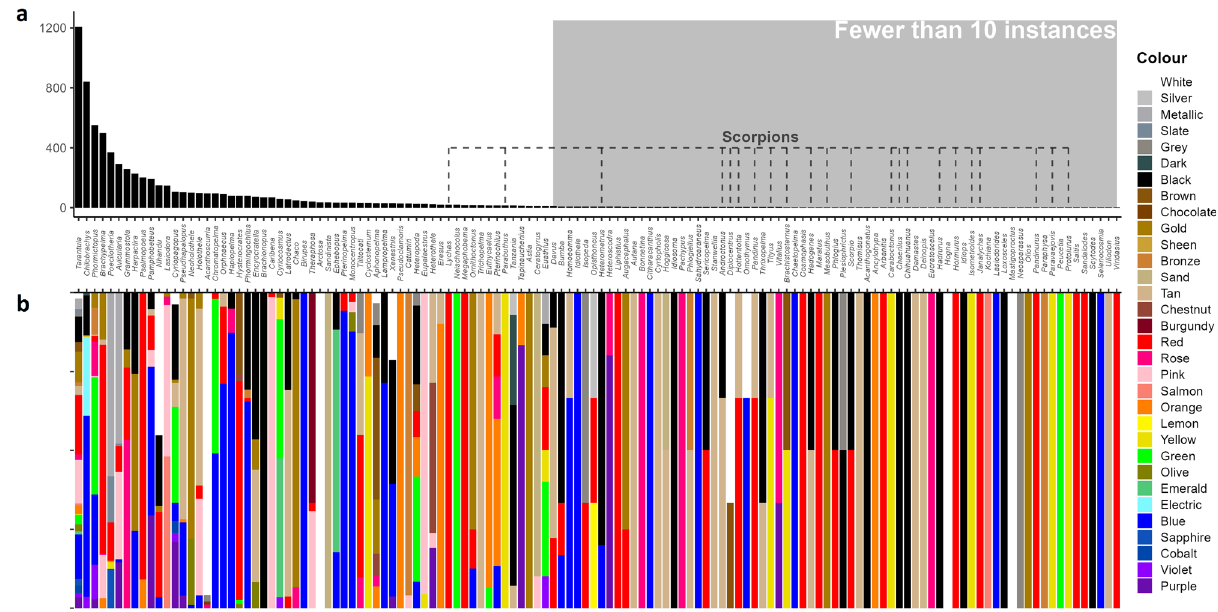
Fig. 4 Count and colours linked to mentions of arachnid genera. a Raw counts of the number of times a genus keyword appeared alongside a mention of colour (based on actual colour listings). Most genera mentioned are spiders, and scorpions are highlighted with grey dashed lines. b The proportion of genera keyword detections linked to a particular colour, with legend detailing the colour word